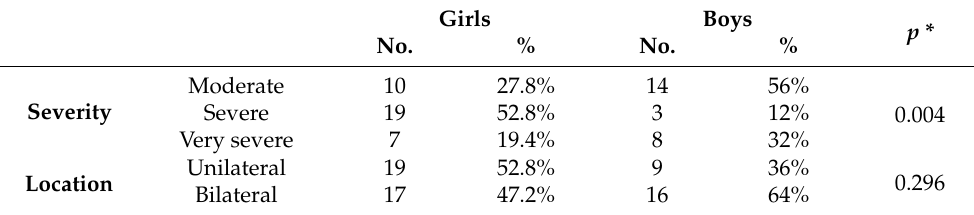
Table 1. Distribution of the patients according to gender and severity/ location of the ectopic molars.